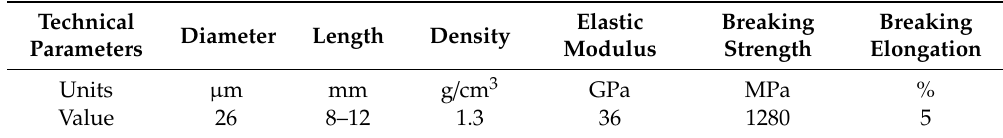
Table A6. Technical parameters of polypropylene fiber.